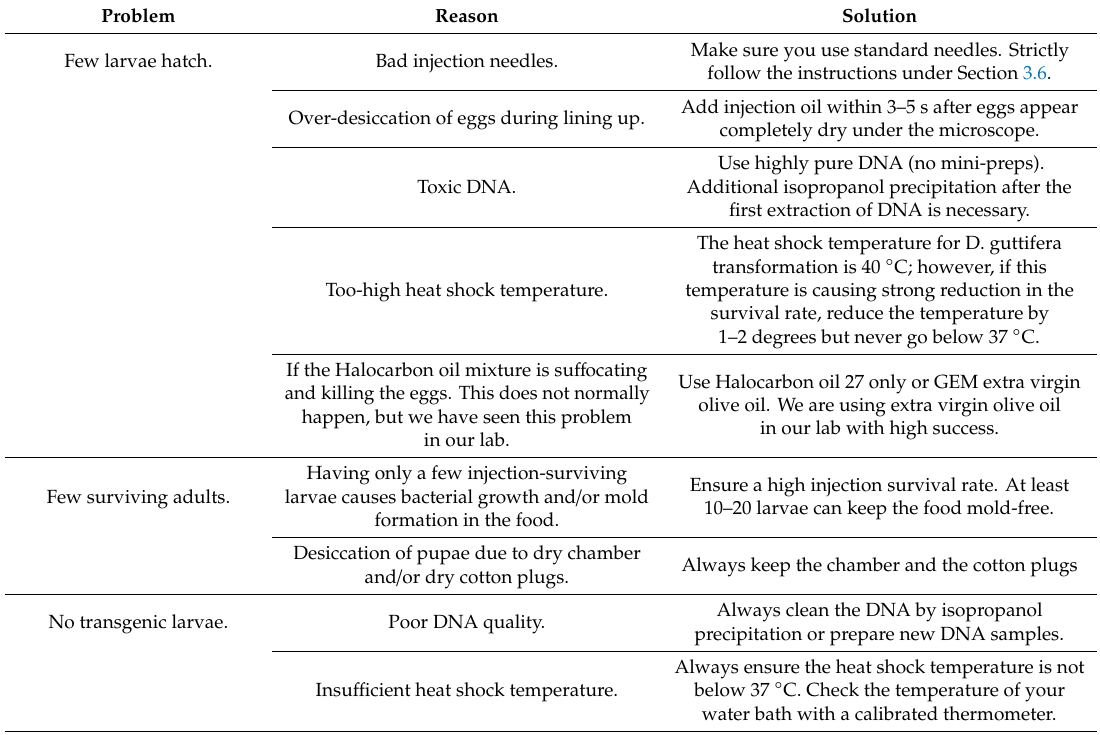
Table 1. Troubleshooting guide (summarizes a variety of problems that we have encountered in the past. The table explains the reasons underlying the problems and o ff ers appropriate actions to work around each